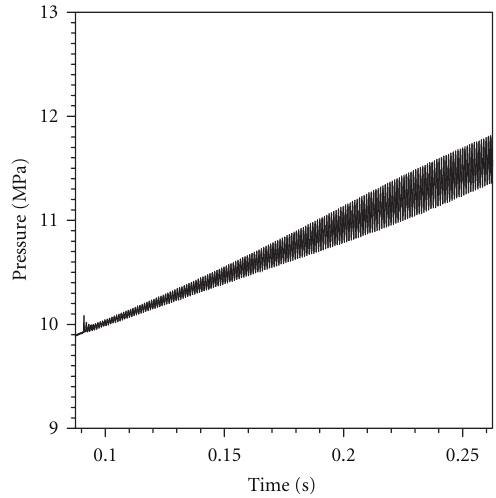
Figure 5: Predicted head-end pressure wave profile, reference motor ( K b = 20000 s − 1 , Δ H s = 150000 J/kg, Δ p d = 2atm, α p = 5%, d m 1 = 10 μ m, d m 2 = 5 μ m, α p 1 = 2 . 5%, α p 2 = 2 . 5%), two particle sets, acceleration nullified. = 2atm, α = p d